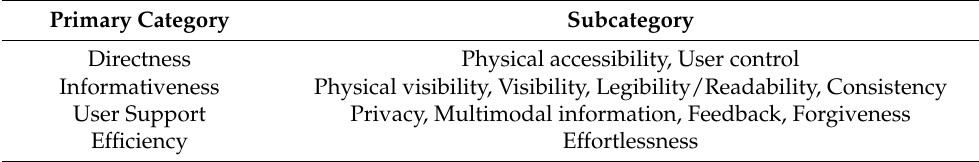
Table 2. Classification of